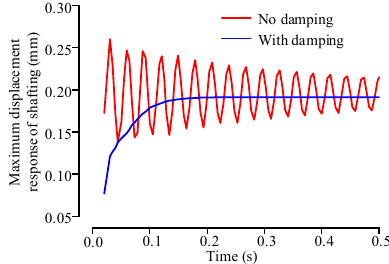
Figure 18. Mechanical response of FE model of the shaft system.